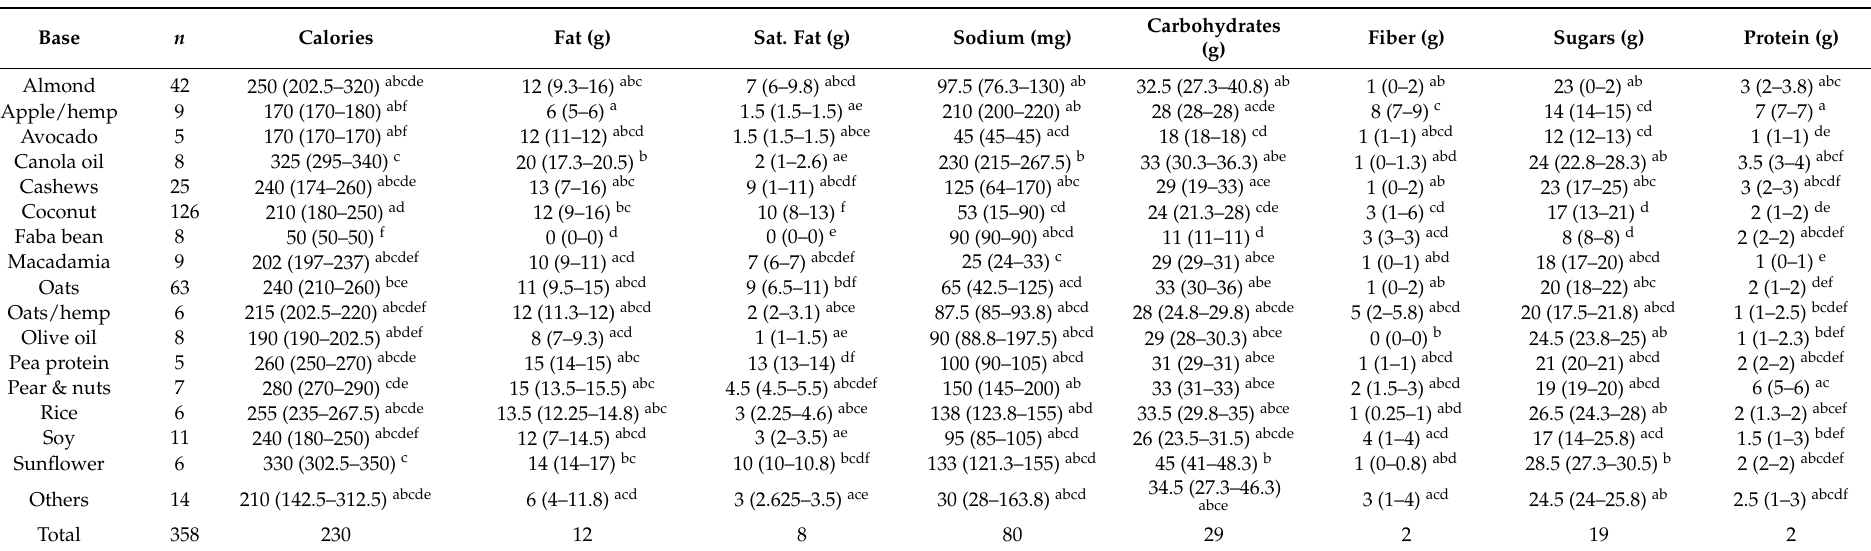
Table 1. The median (Q1–Q3) values of calories and 7 nutrients of non-dairy frozen desserts/serving classified according to their bases. Data are listed for pint containers